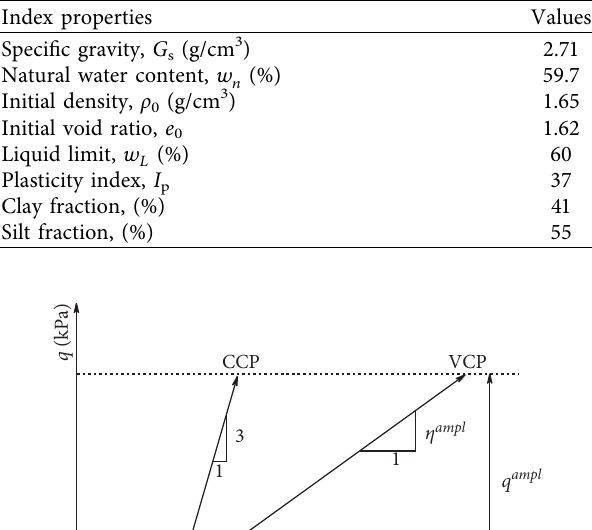
Table 1: Physical index of Wenzhou soft clay.